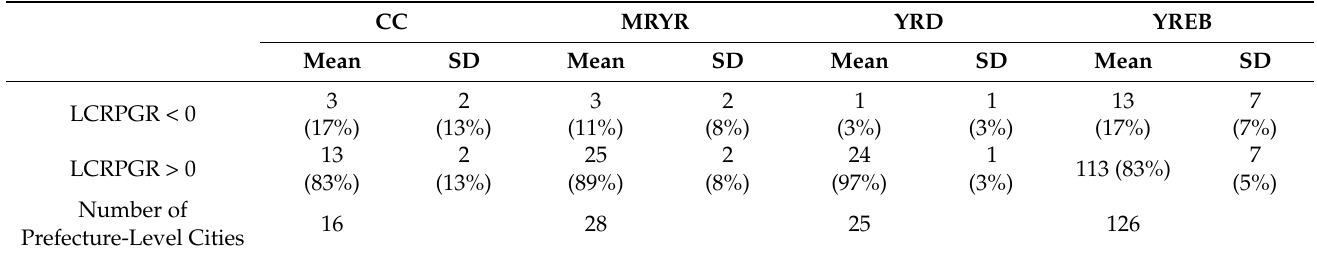
Table 2. Statistics on the number prefecture-level cities of LCRPGR < 0 and LCRPGR > 0 for 2000–